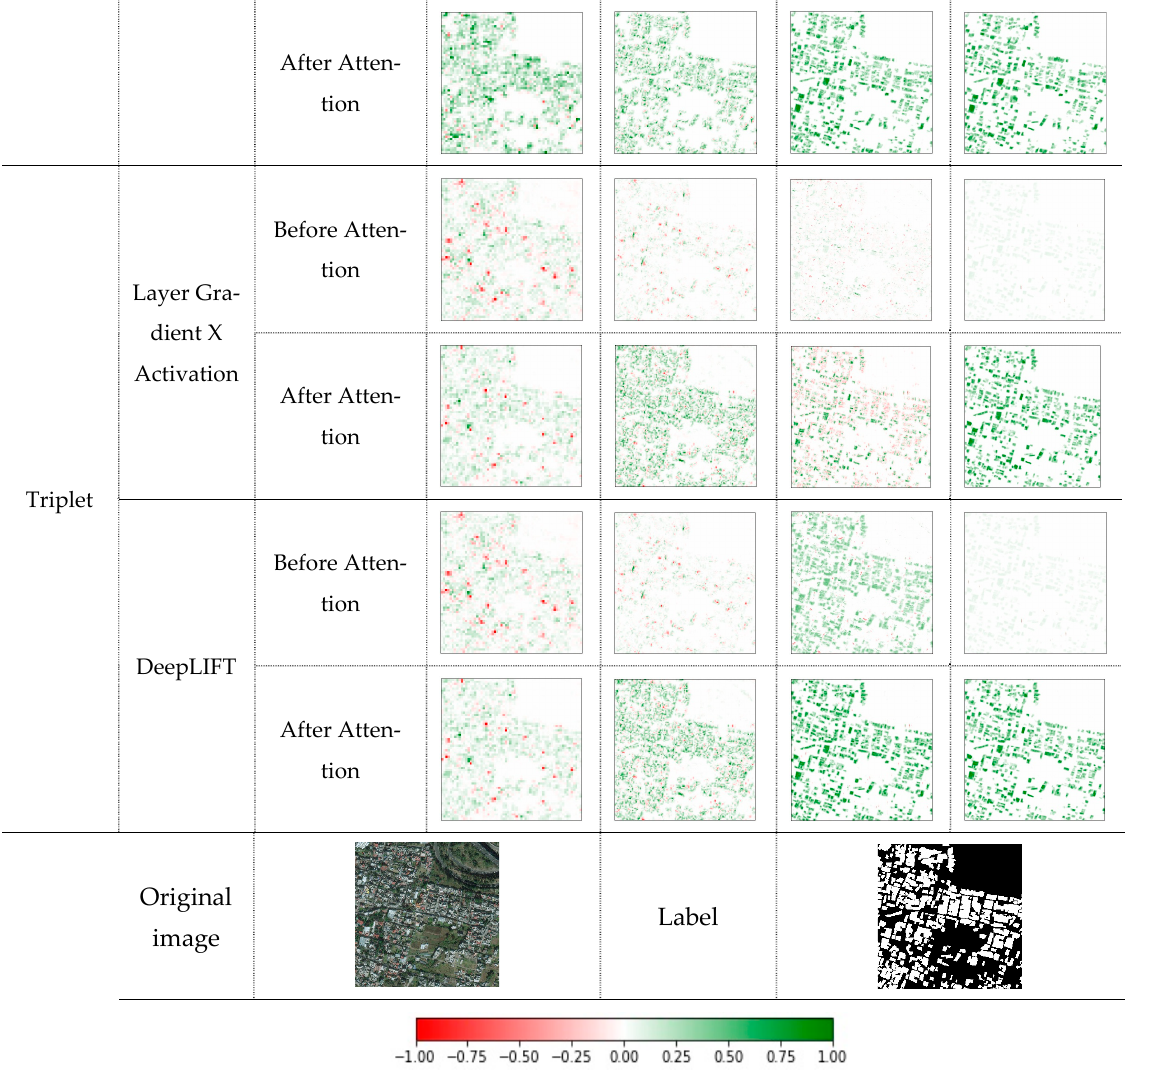
Figure 4. Visualization results of Gradient X Activation and LayerDeepLIFT before and after AMs on SegNet. The numbers above the table (i.e., 1st, 2nd . . . ) indicate the layer number of the attention in the framework.